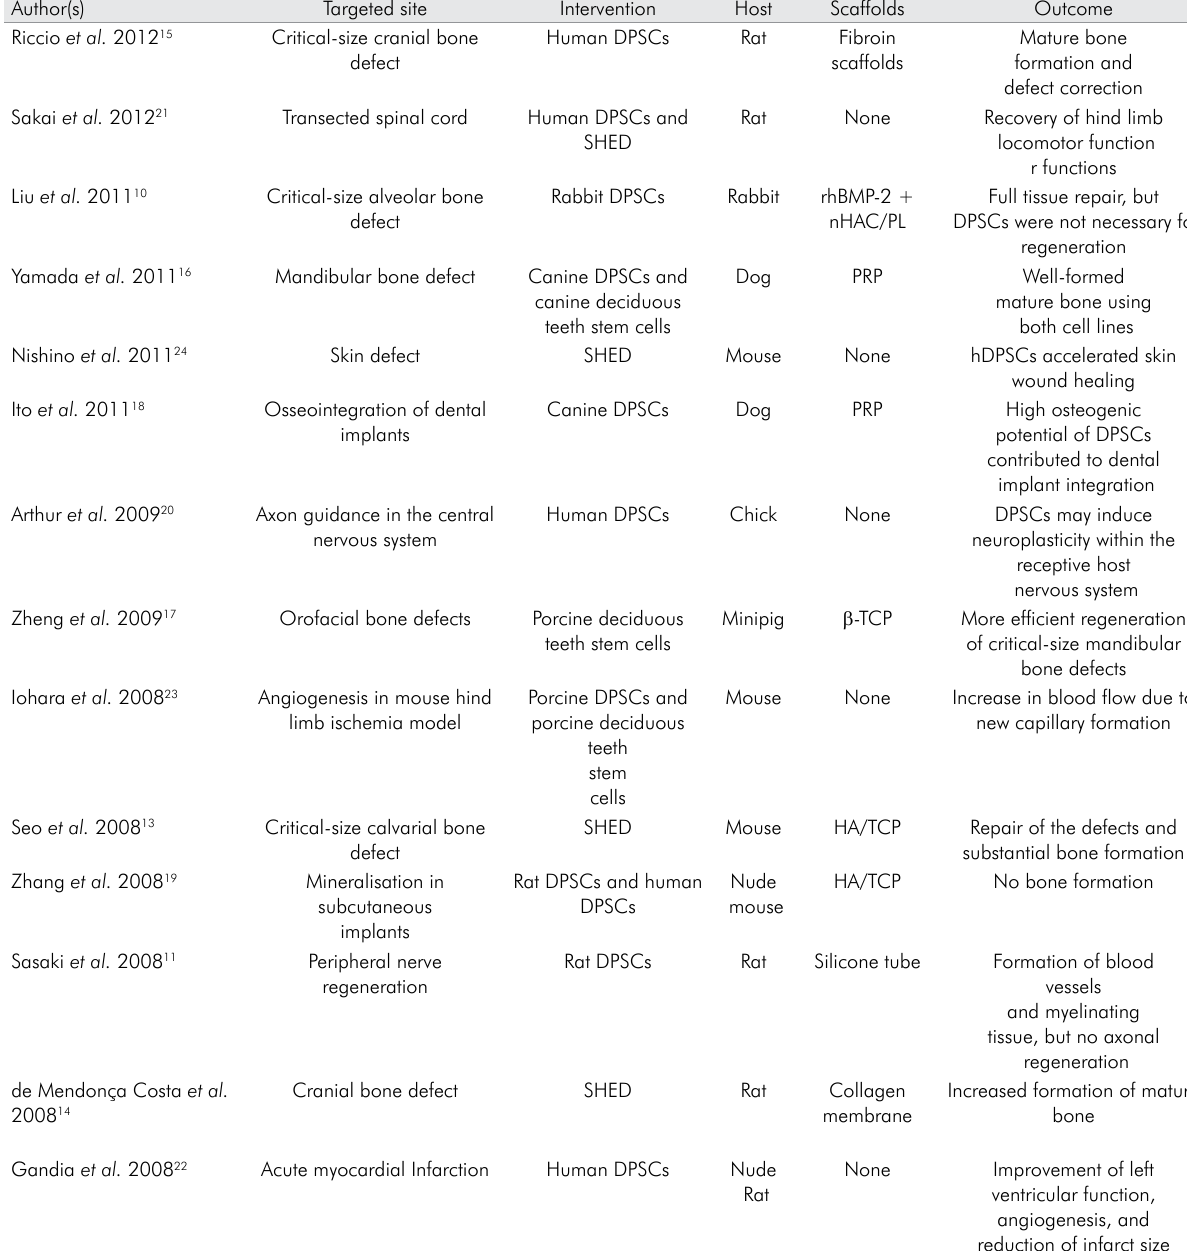
Table 1. Studies that used SHED or DPSCs for the repair and/or regeneration of non-dental